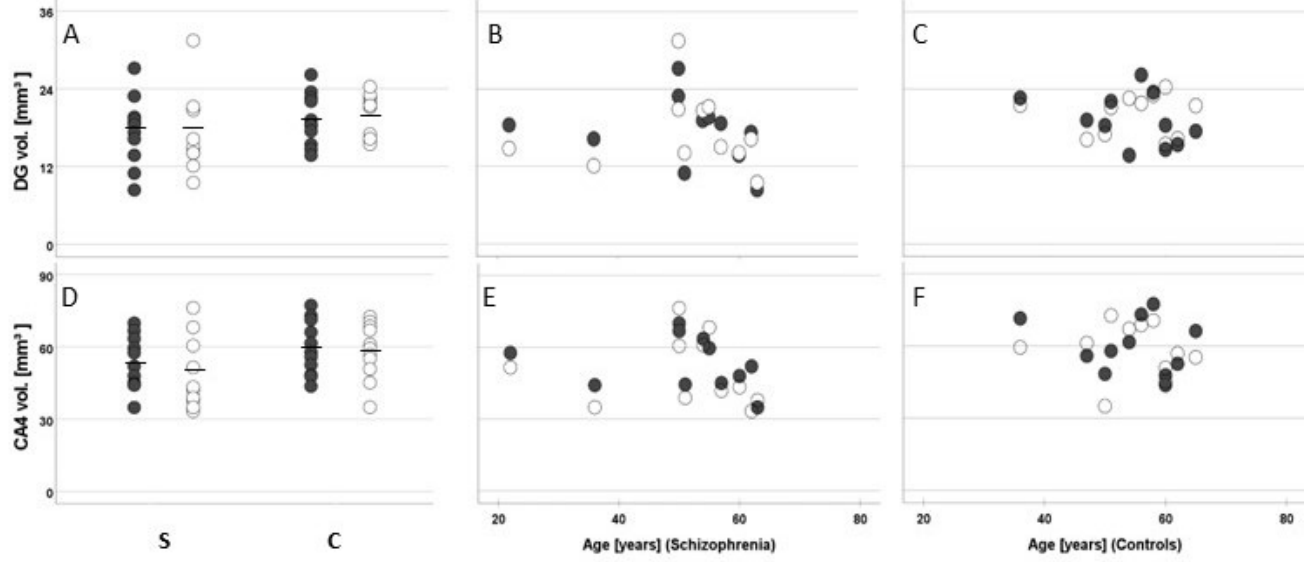
Figure 6. Mean and standard error of the mean ( A , D ) and individual values correlated with age (patients with schizophrenia [S]: ( B , E ); controls [C]: ( C , F ) of the volume (in mm 3 ) of the hippocampal granule cell layer (the dentate gyrus; ( A – C )) and cornu ammonis 4 subfield (CA4; ( D – F )) in postmortem brains from men with schizophrenia and age- and sex-matched controls. Closed dots represent data from the left hemispheres, and open dots, data from right hemispheres.